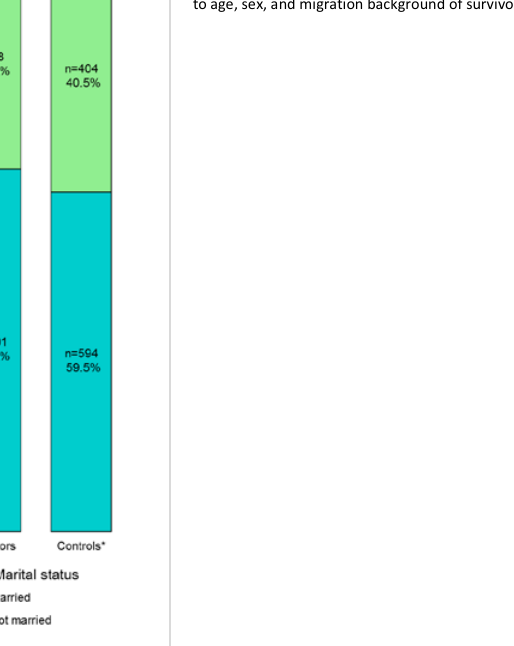
Figure 1: Social outcomes of teenage and young adult cancer survivors in comparison to healthy controls. * Proportions and numbers for controls weighted according to age, sex, and migration background of survivors.